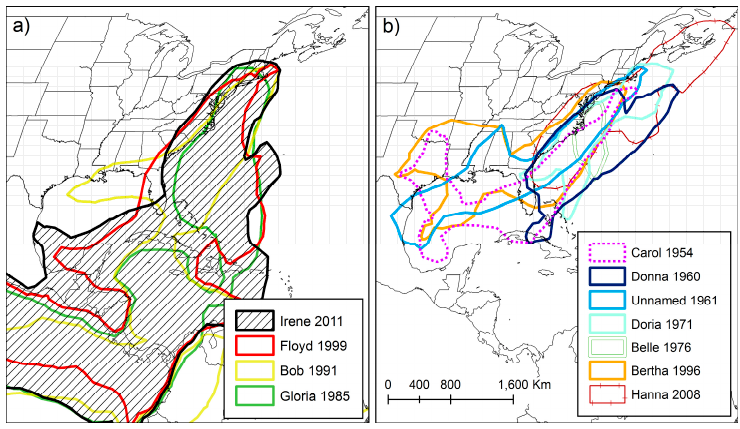
Figure 7. Contours of 45 mm precipitable water for ( a ) four TCs with linkages to deep tropical moisture, and ( b ) seven TCs that do not source their moisture from the deep tropics. Colors correspond to storm tracks in Figure 1.